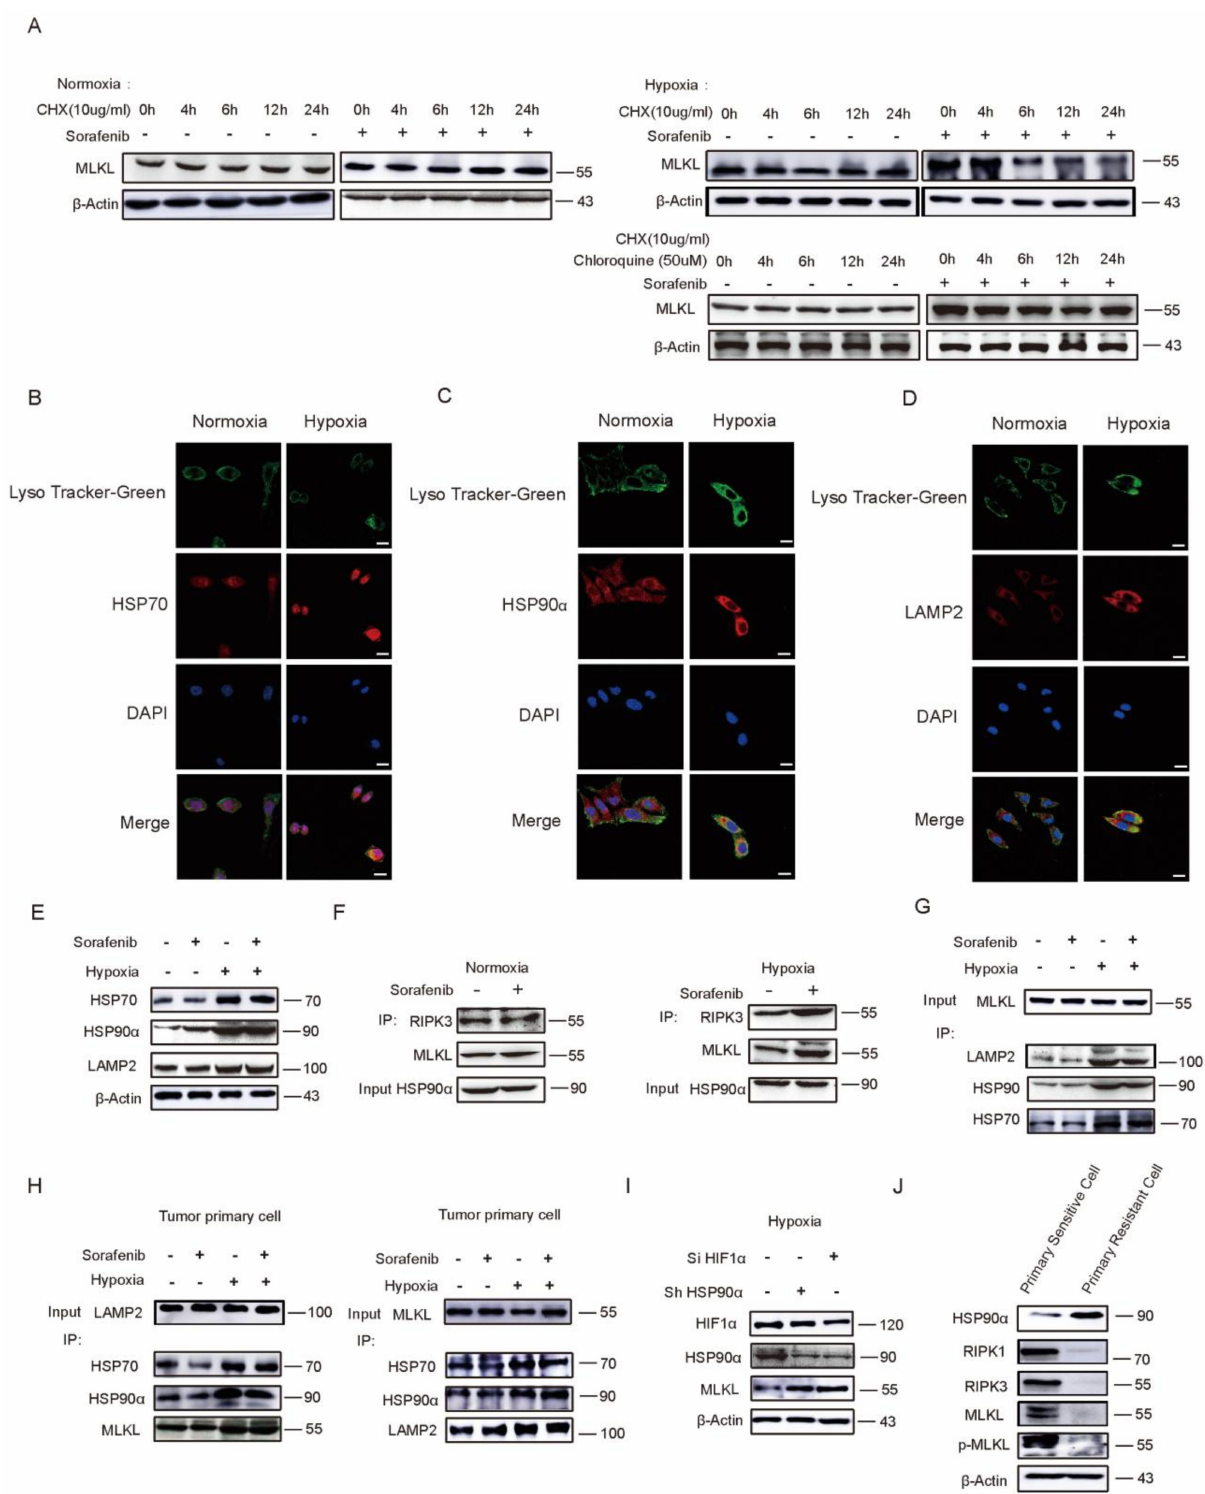
Figure 4. HSP90 α Promotes Chaperone-Mediated Autophagy (CMA) Degradation by directly binding to MLKL in hypoxia. ( A ) The degradation stability of MLKL detected by Western blot. ( B – D ) The expressions of LAMP2, HSP90 α and HSP70 located in lysosomal observed by immunofluorescence. Scale bar = 40 µ m. ( E ) The expression of LAMP2, HSP90 α and HSP70 in hypoxia. ( F ) HSP90 α binding with necroptosis protein. ( G , H ) The expression of LAMP2/HSP90 α /HSP70/MLKL complex detected by Western blot in HepG2 and primary tumor cells. ( I ) Silenced HIF-1 α and HSP90 α affected necroptosis in hypoxia. ( J ) Necroptosis pathway in primary resistant cells detected by Western